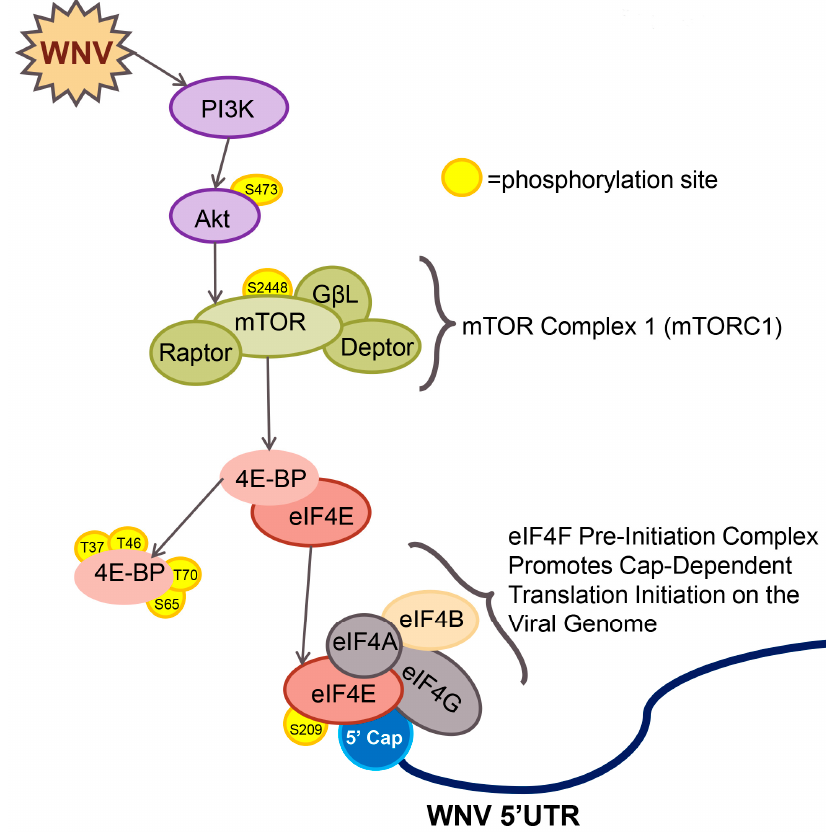
Figure 8. Working model for WNV activation of mTOR and the effect on viral RNA translation initiation events. WNV infection of host cells leads to activation of mTORC1 resulting in increased phosphorylation of the translation-initiation repressor 4EBP and dissociation from eIF4E. Free eIF4E binds to the 5 (cid:48) cap on WNV genomic RNA and assembles the eIF4F pre-initiation complex required for cap-dependent translation of viral RNA, resulting in viral protein expression and viral